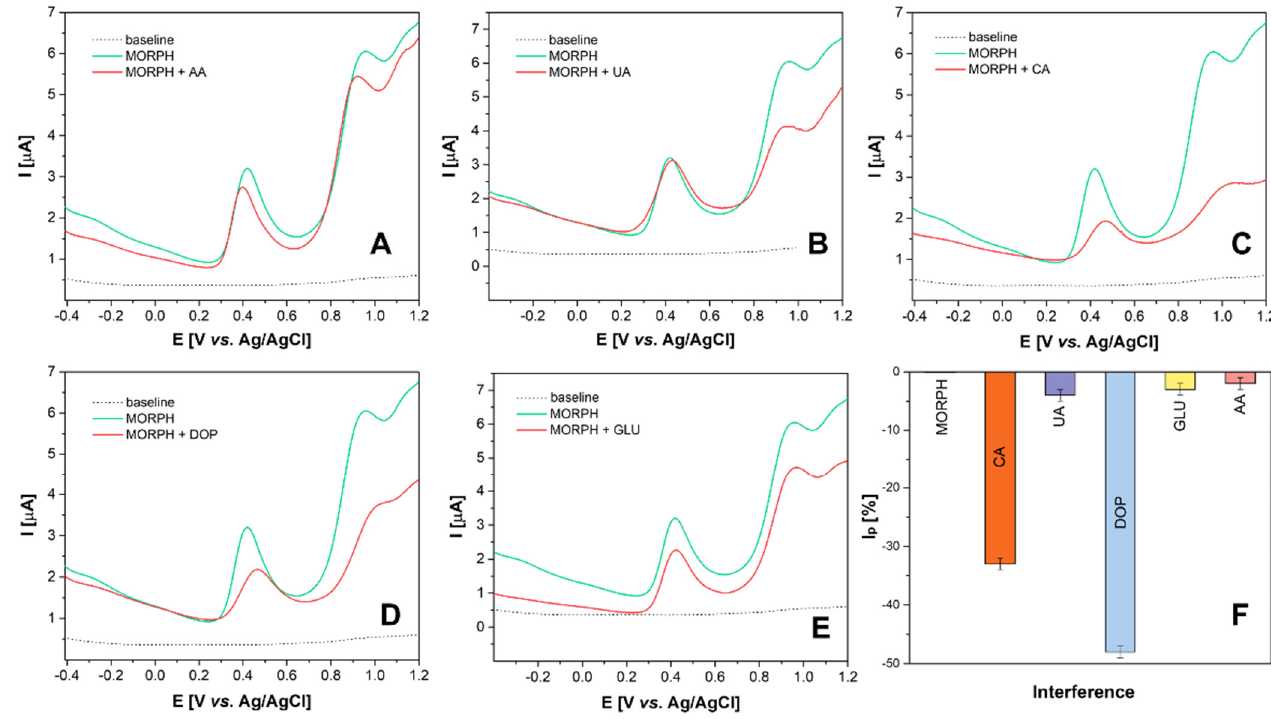
Figure 7. SWV voltammograms of MORPH at Fe 1 W 3 @CPE in absence (green line) and presence (red line) of ( A ) ascorbic acid (AA); ( B ) uric acid (UA); ( C ) citric acid (CA); ( D ) dopamine (DOP); ( E ) glucose (GLU); and ( F ) peak current signal (%) before and after addition of interferents.